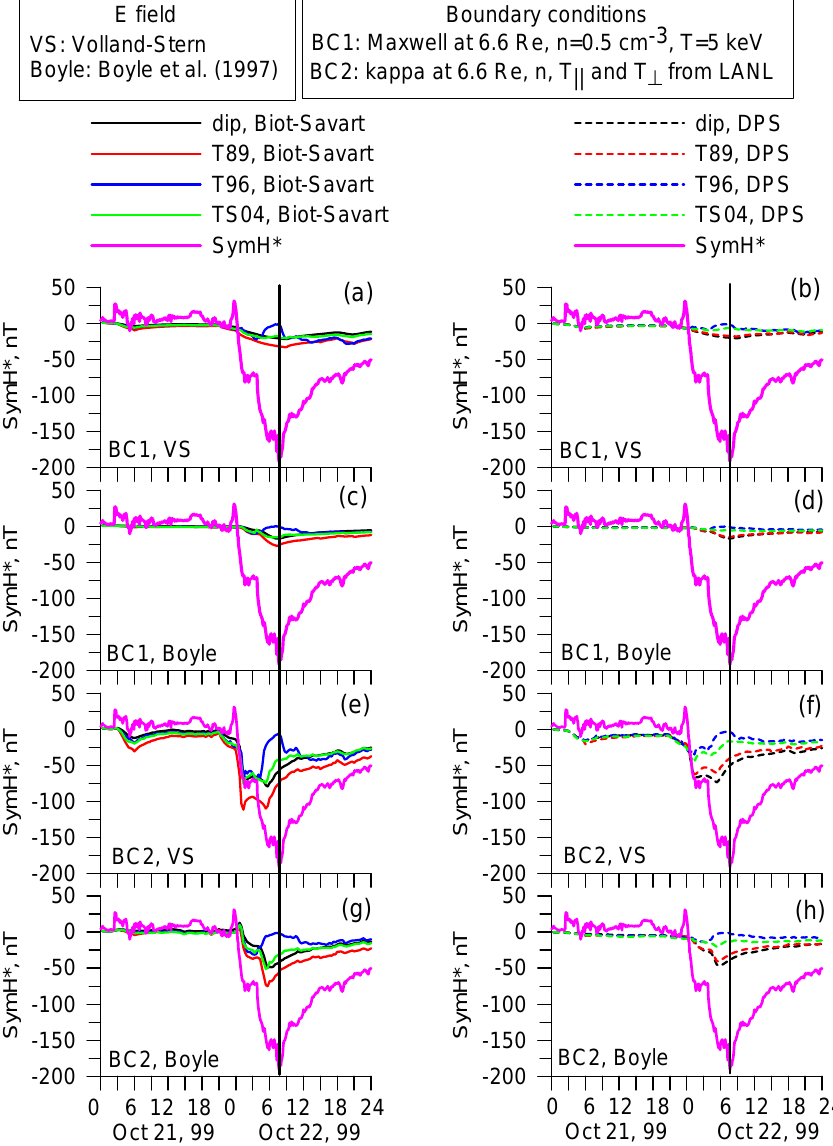
horizontal lines mark the observed SymH* minimum